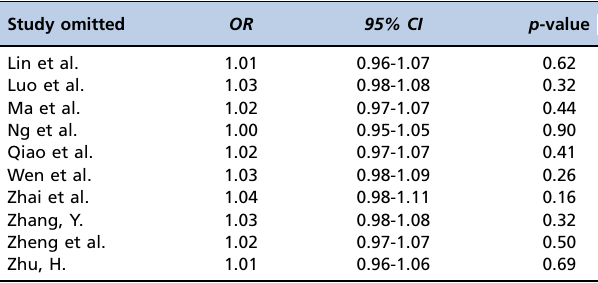
Table 3 - The results of the sensitivity analysis with each rs1119 6218A/G-focused study omitted. Study omitted OR 95% CI